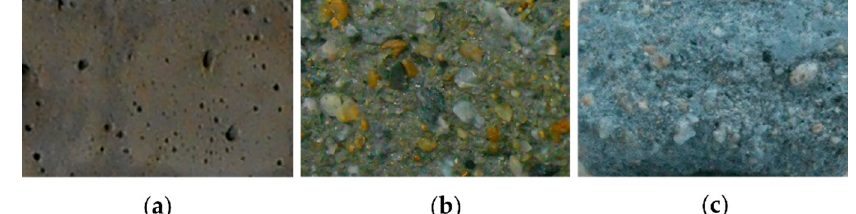
Figure 2. Examples of spacer surface with and without surface treatment: ( a ) the spacer without surface treatment; ( b ) the chloride-resistance small-size coarse aggregate concrete spacer (SS) with surface treatment; and ( c ) the chloride-resistant mortar spacer (MS) with surface